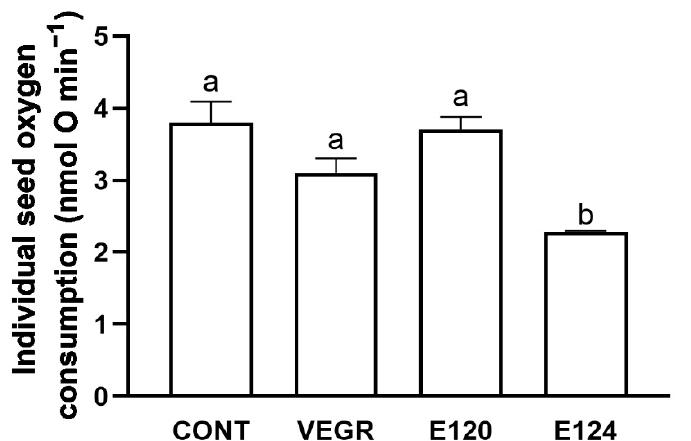
Figure 1. Individual seed dark oxygen consumption in C. sativus control seedlings (CONT) and seedlings treated with different food dyes (VEGR, E120, and E124). Values are means ± SEM ( n = 10). Different letters indicate statistically significant differences among treatments.